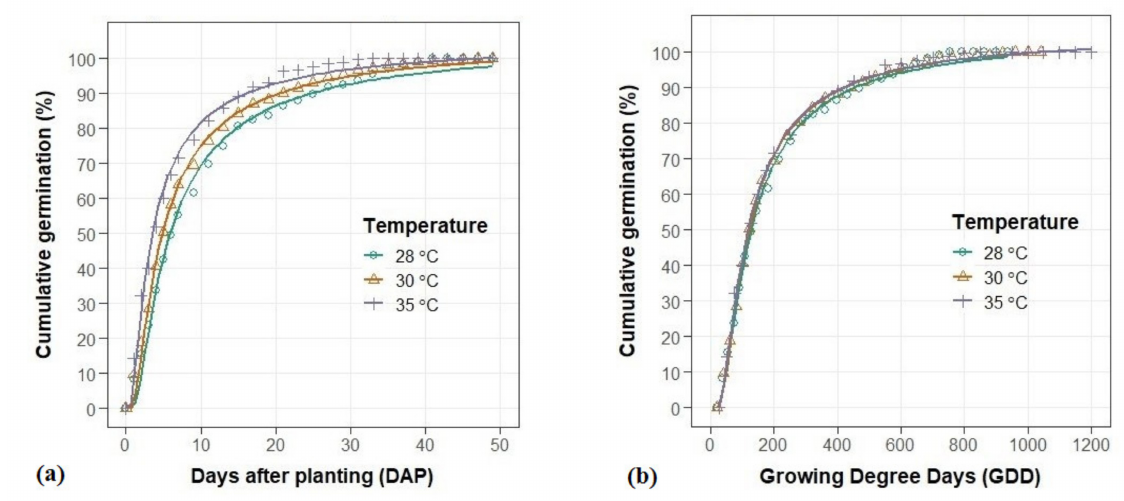
Figure 1. Effects of temperature on cumulative germination (%) of 26 C. campestris populations using ( a ) days after planting (DAP) and ( b ) growing degree days (GDD) as explanatory variables.